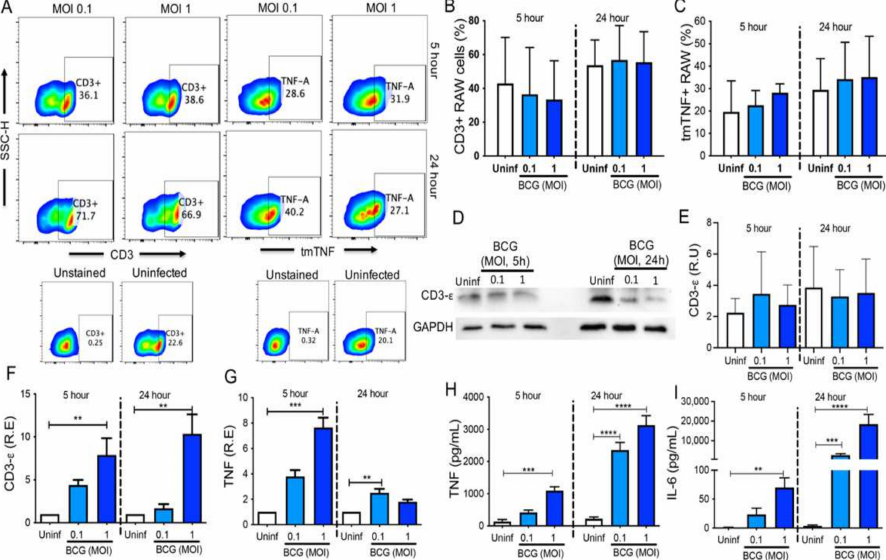
Figure 5. RAW cells increase CD3 and TNF at the transcriptional level after in vitro BCG infection. ( A ) Representative dot plot showing analysis strategy to identify, by flow cytometry, the CD3 and transmembrane TNF (tmTNF) expression in RAW cells uninfected (Uninf) and infected in vitro with BCG MOI 0.1 and 1 during 5 and 24 h. Controls of unstained and uninfected cells are shown down to the respective molecule. Percentage of CD3+ and tmTNF+ RAW cells evaluated by flow cytometry (( B , C ), respectively). ( D ) Immunoblot evaluation of CD3- Σ in lysates of uninfected and infected RAW cells. GAPDH was used as a loading control. ( E ) Relative units (R.U) of CD3- ε and TNF expression evaluated by immunoblot, and relative expression (R.E) of CD3- ε and TNF genes assessed by qPCR in uninfected and infected RAW cells (( F , G ), respectively). Quantification of soluble TNF and IL-6 by ELISA in culture supernatants from uninfected and infected RAW cells (( H , I ), respectively). n = 7 independent experiments (for flow cytometry), n = 5 independent experiments (for immunoblot), and n = 7 independent experiments performed in triplicate (for qPCR and ELISA). Bars represent the mean value ± SD ( B , C , E ) or the mean of means ± SEM ( F – I ). Kruskal–Wallis and corrected for the Dunn test were used for flow cytometry and immunoblot analysis, and one-way ANOVA followed by Bonferroni test for qPCR and ELISA data. ** p < 0.01, *** p < 0.001, **** p <